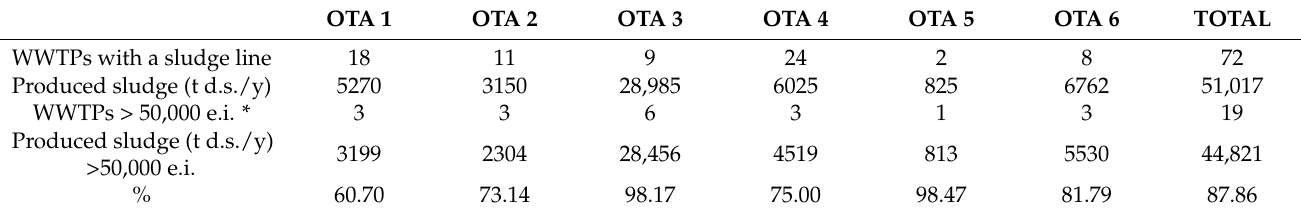
Table 4. Production of sewage sludge for WWTPs with a treatment capacity of more or less than 50,000 e.i. OTA